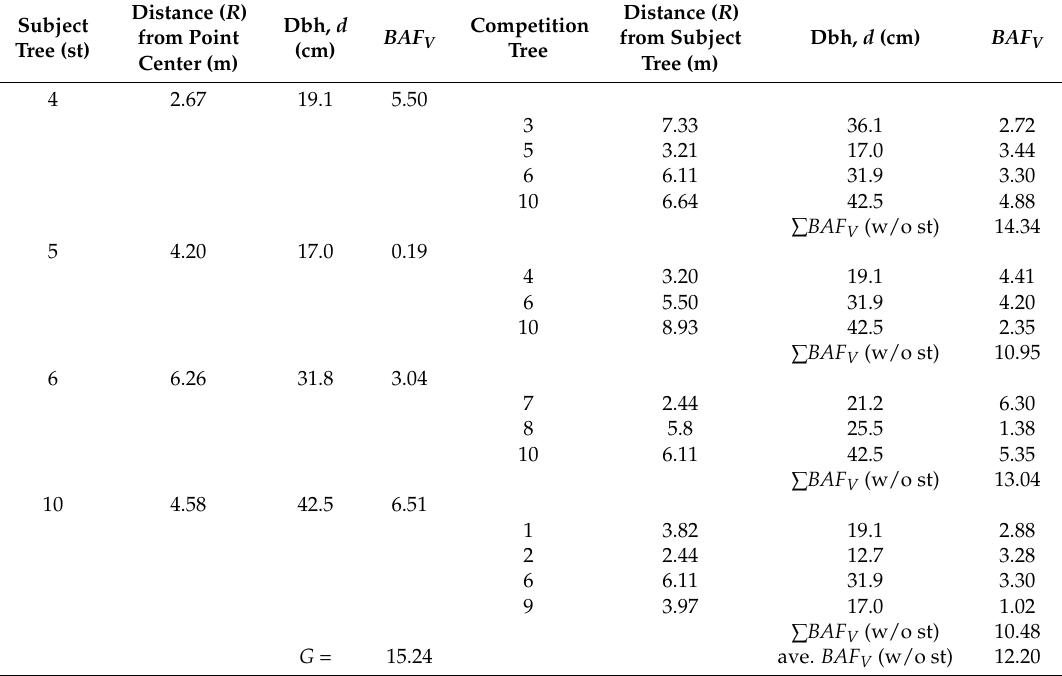
Table A1. Computations for achieving compatibility between the stand-level estimate of basal area and the assignment of individual-tree competition indices. BAF AC = 4.